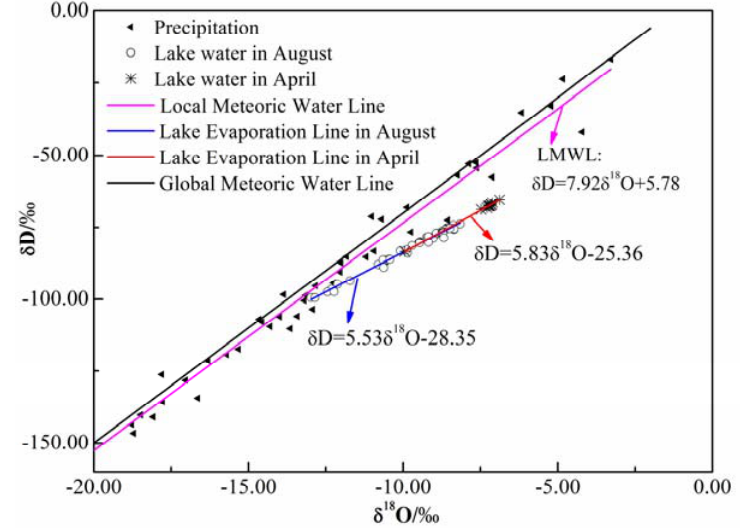
Figure 5. The relation line of hydrogen and oxygen isotope in precipitation and lake water.